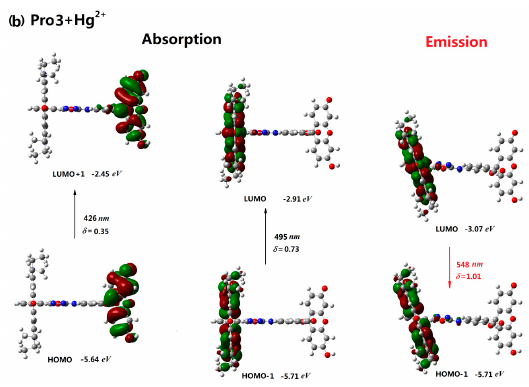
Figure 5. The absorption and emission of ( a ) Pro3 and ( b ) Pro3+Hg 2+ in H 2 O.